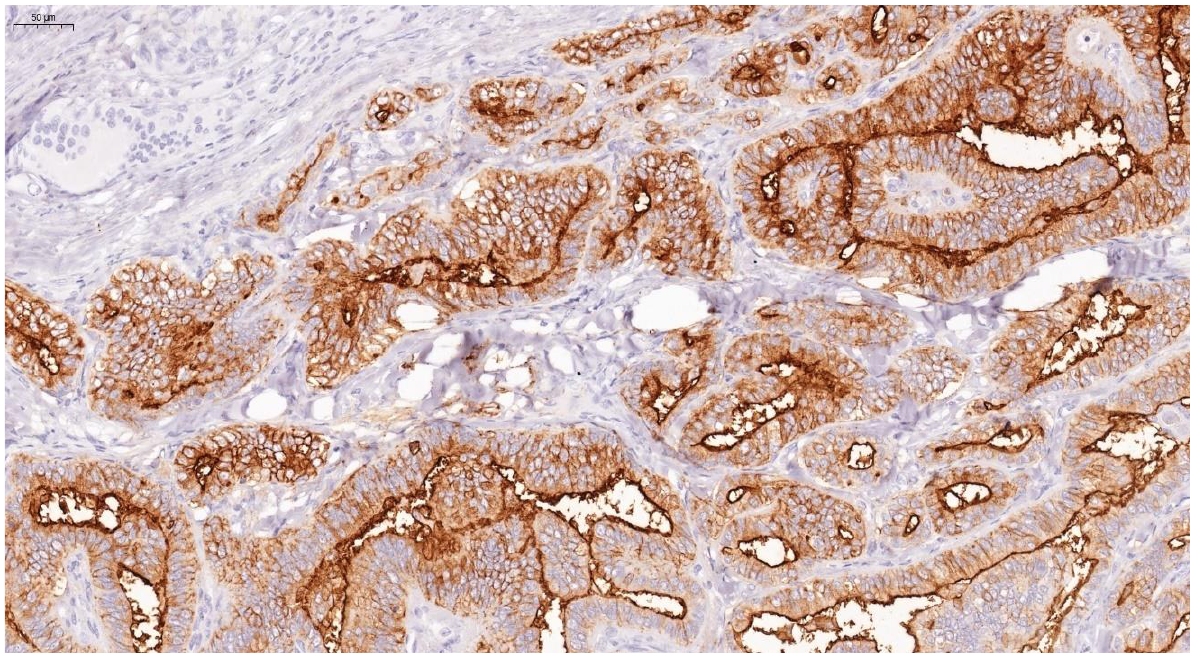
Figure 11. HBME-1 showing strong membranous and cytoplasmic staining as brown, after IHC in papillary thyroid carcinoma (×100).